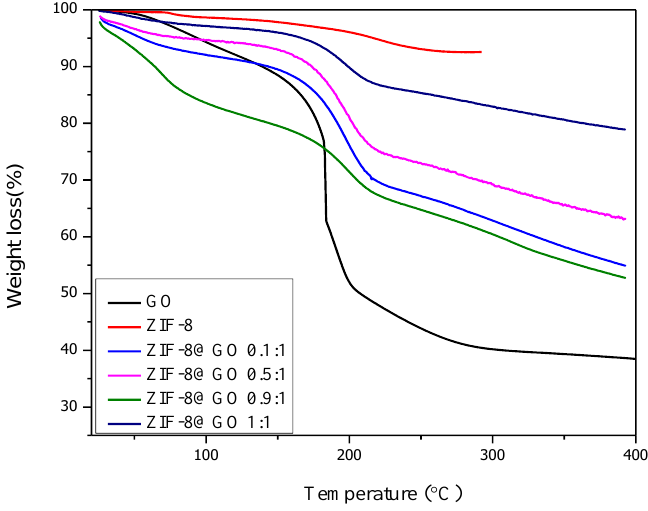
Figure 7. TGA curves representing decomposition profiles of GO, ZIF-8 and ZIF-8@GO composites.